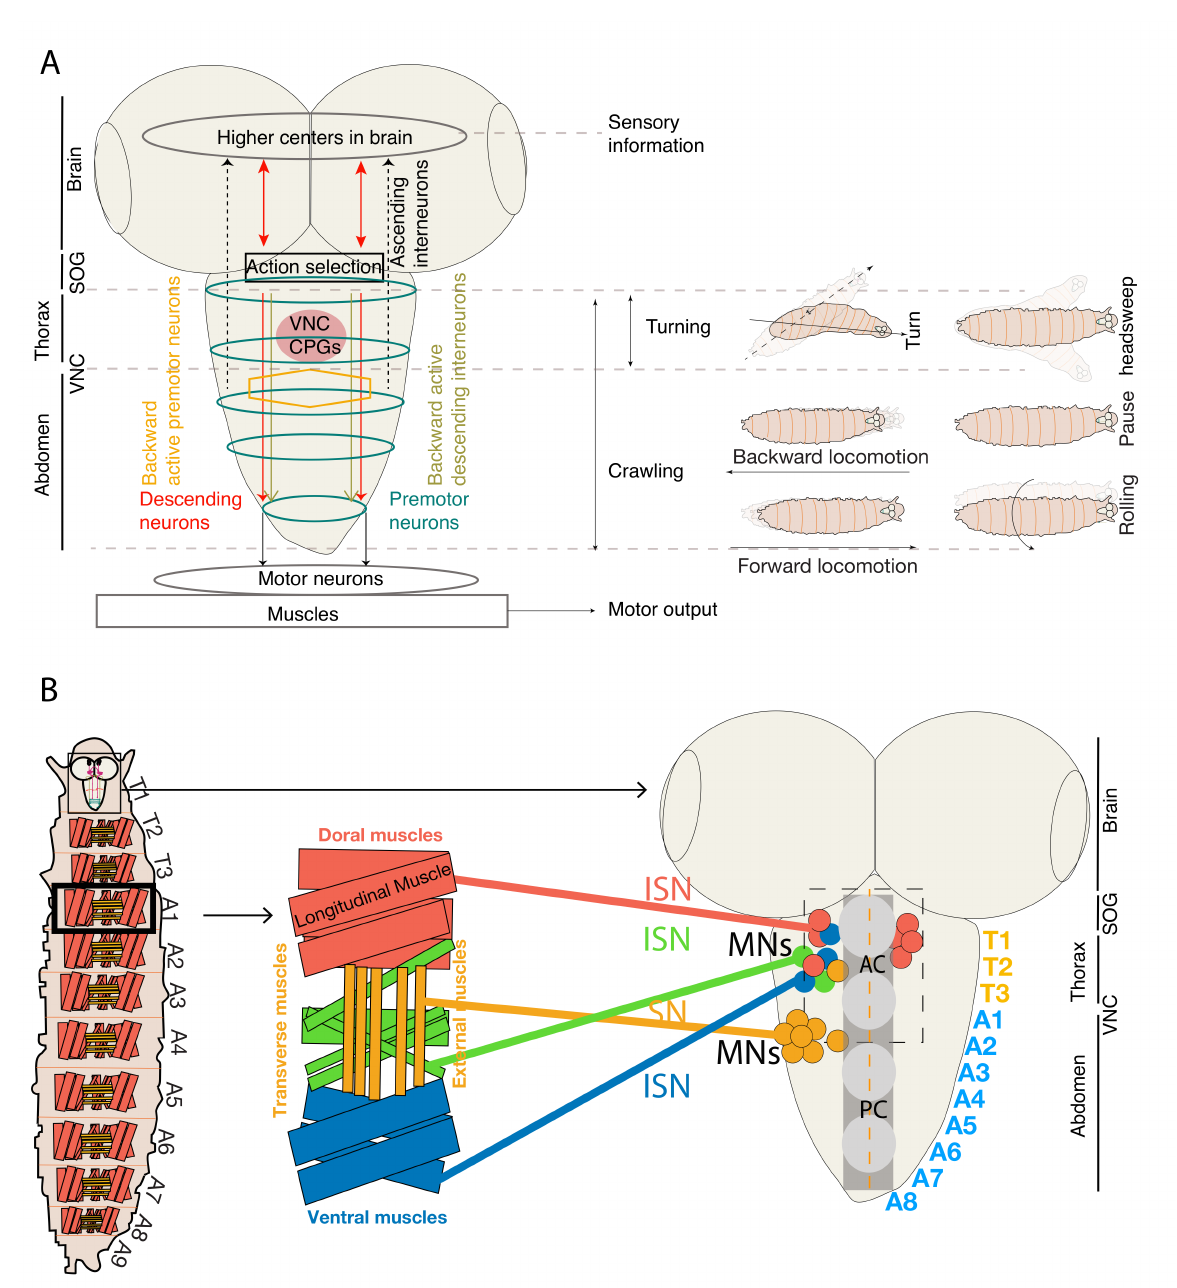
Figure 1. Schematics of topological organization, myotopic map and CNS regions involved in locomotion. ( A ) Schematics of organization of various types of neurons and thoracic and abdominal regions involved in various larval locomotor behaviors. ( B ) Schematic representation of Drosophila larval central nervous and neuromuscular system, which is divided into brain, subesophageal ganglia (SOG), and ventral nerve cord (VNC). In VNC, the positions of MNs cell bodies and representative muscle innervations are shown. MNs innervate abdominal hemisegments of each muscle through an intersegmental nerve (ISN, shown in red, blue and green), and segmental nerve (SN, shown in golden) which innervate internal and external (shown in golden) muscles, respectively. MN dendrite position in relation to their target muscles form a myotopic map. AC—Anterior commissure, PC—Posterior commissure (adapted and modified from